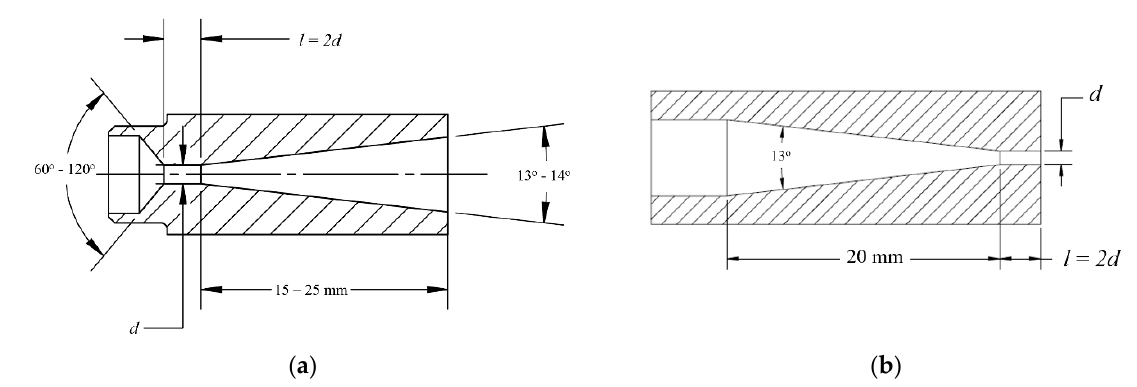
Figure 1. Geometry of cavitation nozzles ( a ) and conic hydrodynamic nozzles ( b ).